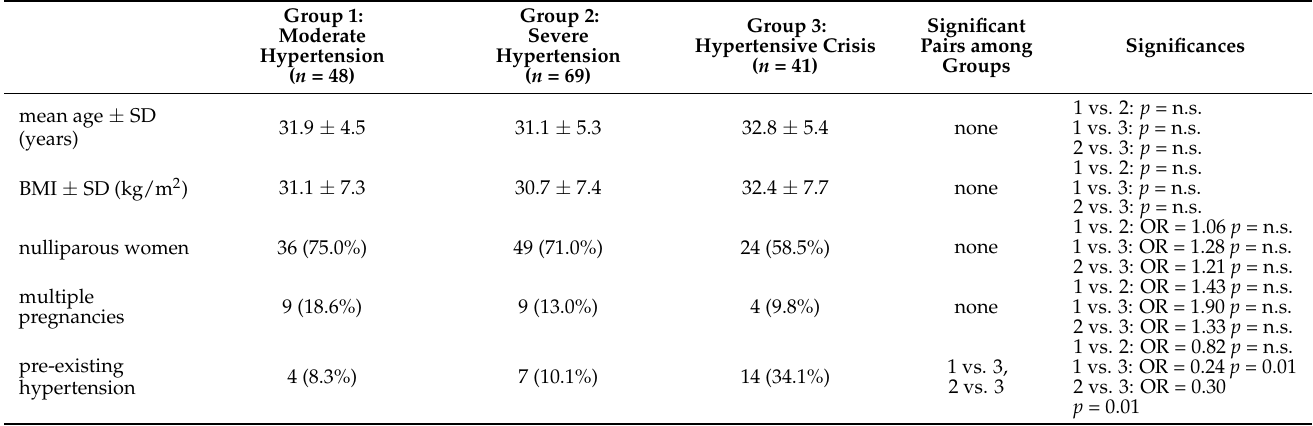
Table 1. Patient characteristics within the blood pressure